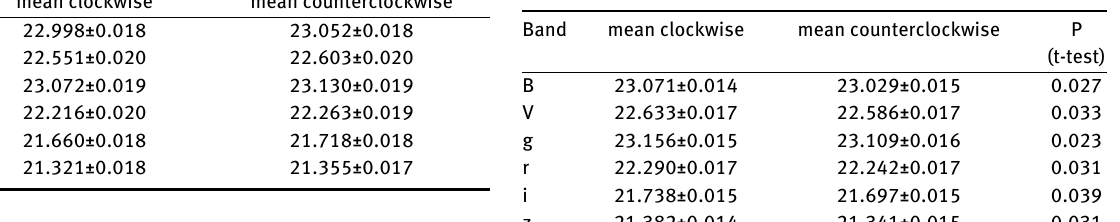
Table 3. Median values of the magnitude of clockwise galaxies and counterclockwise galaxies in COSMOS.